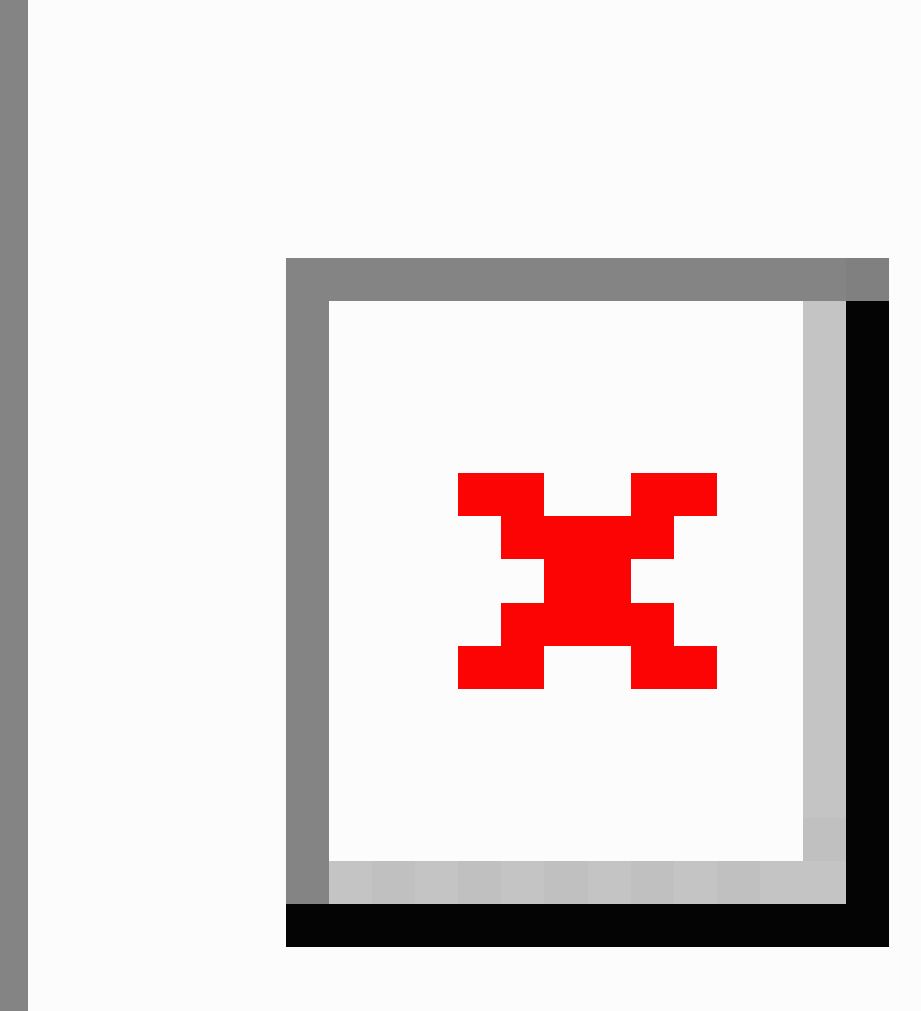
Figure 1. A-CHESS main